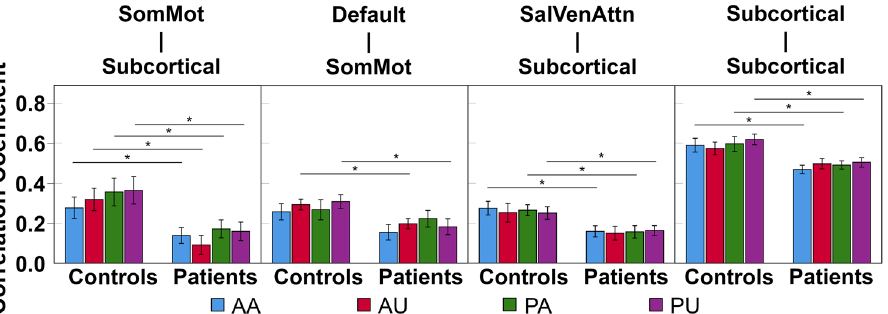
Figure 3. Altered network-specific reconfigurations at different task demands in stroke patients. At the network-level, stroke patients presented network-specific brain network reconfiguration compared to healthy controls. Stroke patients had higher task-related reconfiguration (i.e., lower correlation coefficient) between SomMot and subcortical networks across all tasks. Stroke patients also showed higher reconfiguration between default and SomMot networks during AU and PU tasks. Except the AU task, stroke patients presented higher reconfiguration in SalVenAttn and subcortical inter-network as well as subcortical intra-network. Data are presented as mean ± standard error, * p < 0.05. AA active-affected, AU active-unaffected, PA passive-affected, PU passive-unaffected, SalVenAttn salience/ventral attention, SomMot somatomotor.